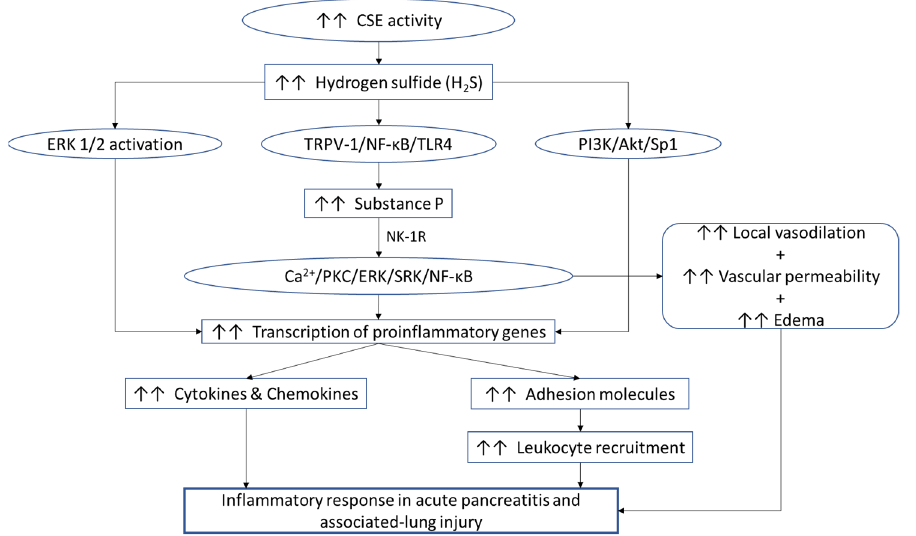
Figure 4. Interaction of H 2 S, substance P, and adhesion molecules in the regulation of inflammatory response in acute pancreatitis.